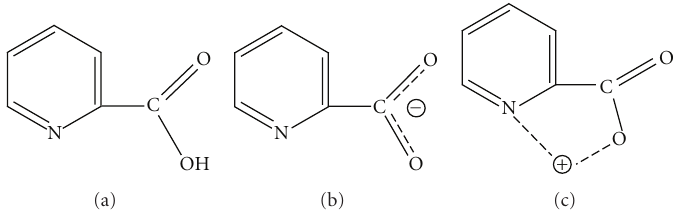
Figure 2: PA molecule (a), PA anion (b), and PA chelation of cation